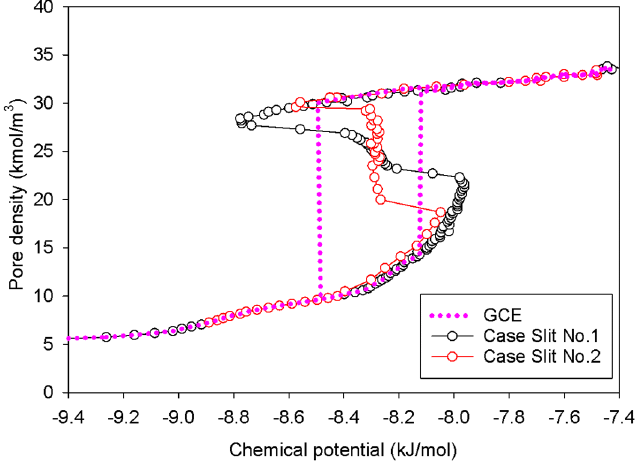
Figure 4. GCE and MCE nitrogen adsorption isotherms in the infinite slit pore of 5 nm width at 77 K.